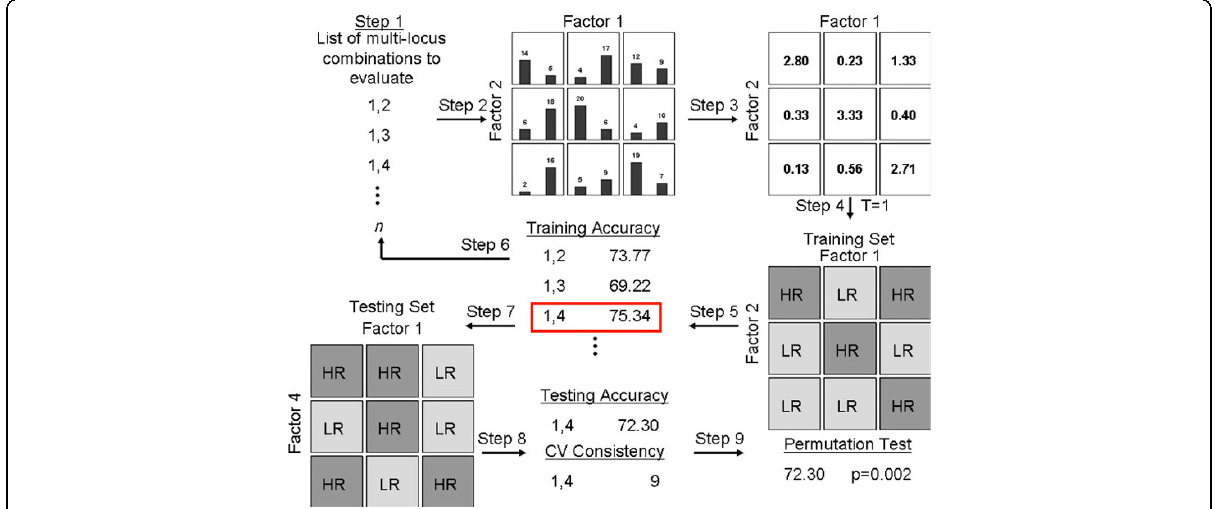
Figure 1 Summary of the general steps to implement the MDR method, adapted from Ritchie and Motsinger 2005 [52]. In step one, the exhaustive list of n combinations are generated from the pool of all independent variables. In step two, for k = 1 to N , the combinations are represented in k -dimensional space, and the number of responders and non-responders are counted in each multifactor cell. In step three, the ratio of responders to non-responders is calculated within each cell. In step four, each multifactor cell in the k -dimensional space is labeled as high-likelihood/high-risk if the ratio of responsive individuals to non-responsive individuals exceeds a threshold and low-likelihood/low-risk if the threshold is not exceeded. In step five the training accuracy is calculated. This is then repeated for each multifactor combination. In step seven, the model with the best training accuracy is selected and evaluated in the test set. In step eight, the testing accuracy of the model is estimated. In step nine a permutation test is conducted to determine the statistical significance of the model(s). Steps 1 through 6 are repeated for each possible cross-validation interval. Bars represent hypothetical distributions of responders (left) and non-responders (right) with each multifactor combination. Dark-shaded cells represent high-likelihood genotype combinations while light-shaded cells represent low-likelihood genotype